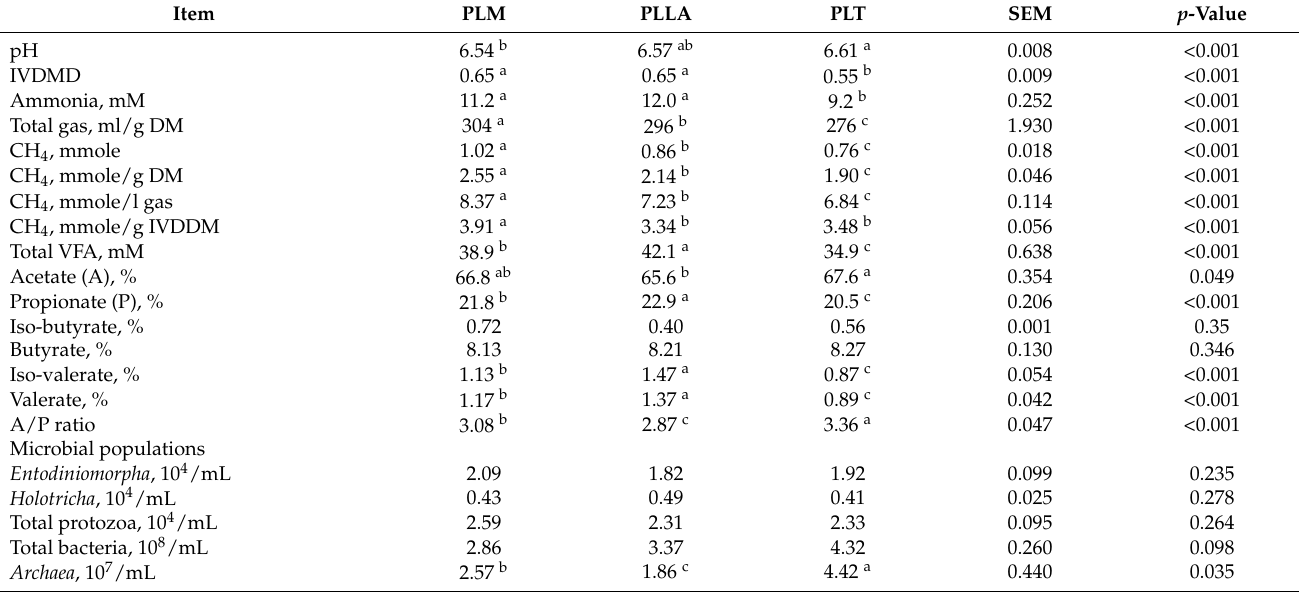
Table 4. The effect of Paulownia leaves with medium concentration of phenolic compounds (PLM), Paulownia leaves lamina (PLLA), and Paulownia twigs (PLT) on in vitro ruminal fermentation, methane production, and microbial populations (experiment